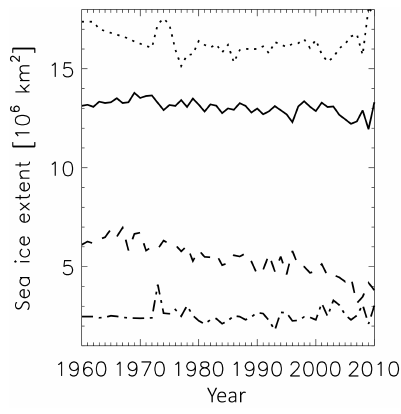
Figure 4. Maximum and minimum monthly mean sea ice extent in the HadISST climatology. Dotted: Antarctic maximum; solid: Arc- tic maximum; dashed: Arctic minimum; dot-dashed: Antarctic min- imum.